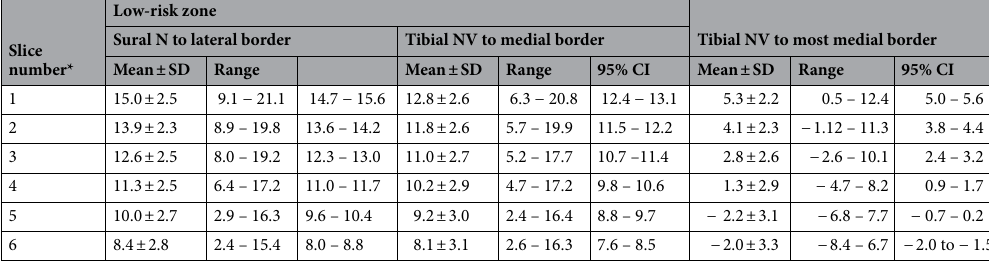
Table 1. Distance of neurovascular structures from the borders of the low-risk zone. * T1 oblique axial slices were made with a thickness of 2 mm parallel to the trajectory of the pin fixation which was from the center of the calcaneal tuberosity to the to the distal tip of the posterior malleolus (slice 1). The values (mm) are presented as the mean with the standard deviation, range and 95% confidence interval. The negative ( −) values indicate that the neurovascular structures crossed the border. N nerve, NV neurovascular structure, SD standard deviation, CI confidence interval.